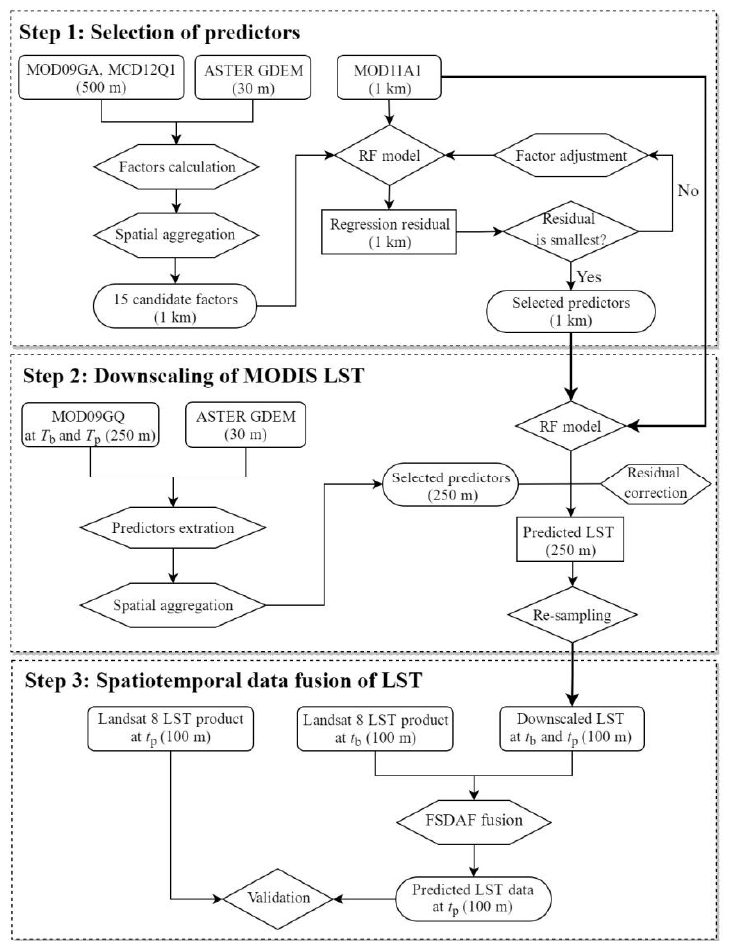
Figure 2. Implementation flowchart of the new framework.